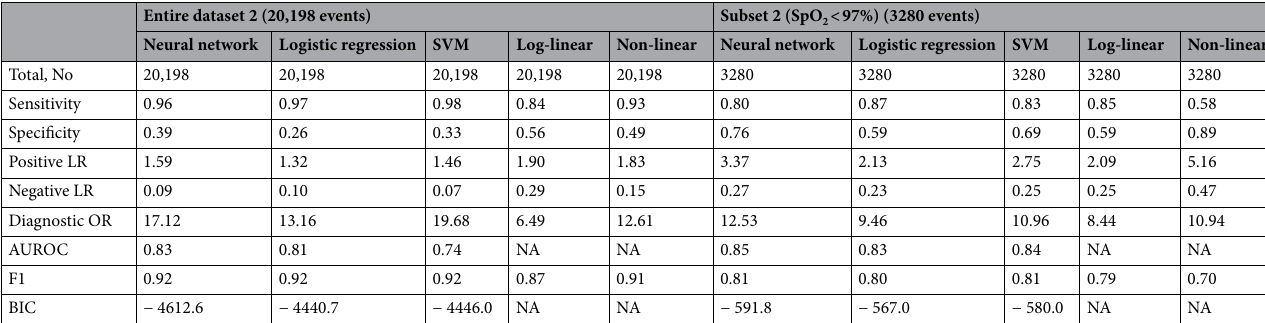
Table 4. Prediction performance of machine learning classification models based on three features. Prediction performance statistics were calculated for the machine learning models based on three features and compared to the Log-linear and Non-linear methods for the entire dataset (20,198 ICU events; entire dataset 2) and for a subset of the events where SpO 2 < 97% (3280 events; subset 2). Variables included in the 3-feature machine learning models are SpO 2 , FiO 2 , and PEEP. PaO 2 : SVR Support vector regression, AUROC area under receiver operating characteristic curve, BIC Bayesian information criterion, LR likelihood ratio, OR odds ratio.